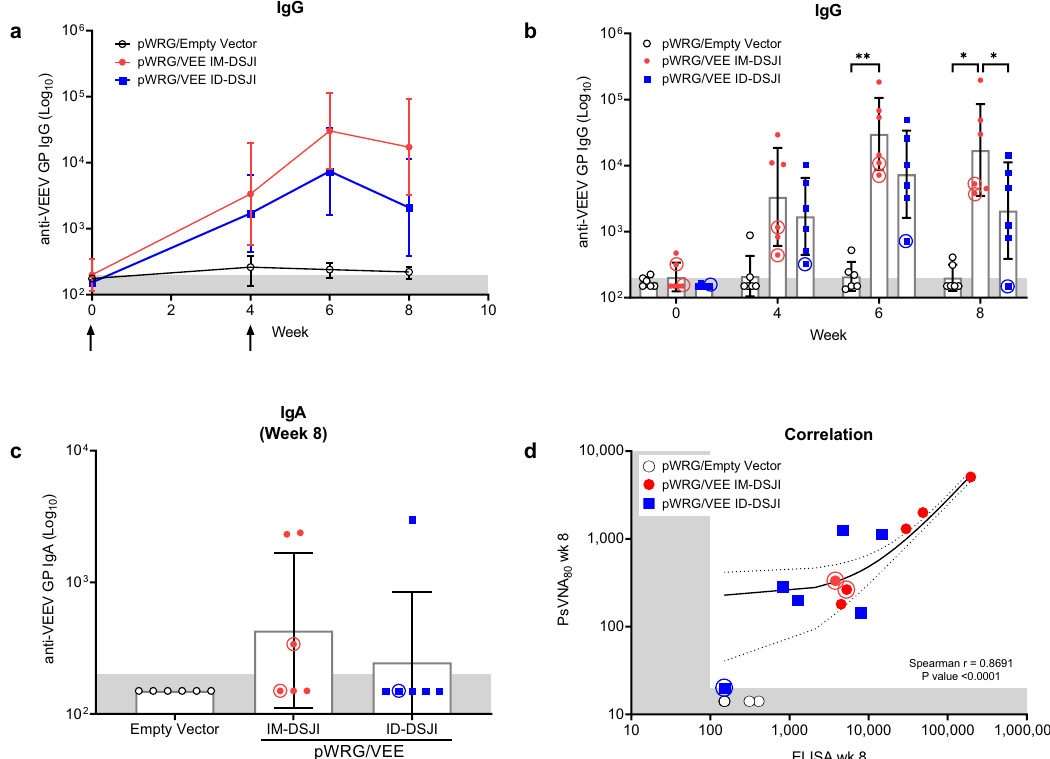
Fig. 1 pWRG/VEE delivered by IM- or ID-DSJI elicits anti-VEEV GP binding antibodies. a Temporal anti-VEEV GP IgG responses and ( b ) total IgG antibody titers in vaccinated nonhuman primates (NHPs). c Total IgA antibody titers 4 weeks after the second vaccination in vaccinated NHPs. The shaded areas represent the assay limit based on the lowest sera dilution tested. Arrows represent vaccination time points. Data represent the group geometric mean ± geometric SD. * p < 0.05, ** p < 0.01. d Correlation analysis of the VEEV ELISA and PsVNA 80 . For panels ( a ) and ( c ), p values were determined by one-way ANOVA with Tukey ’ s multiple comparison test. For panel ( b ), p values were determined by two- way ANOVA with Tukey ’ s multiple comparison. For panel ( d ), linear regression and 95% CI is shown as line and dotted lines, respectively. Circled symbols represent individual NHPs in VEEV-vaccinated groups that developed fever (de fi ned as >3 SD above baseline lasting for more than 2 h) following VEEV aerosol